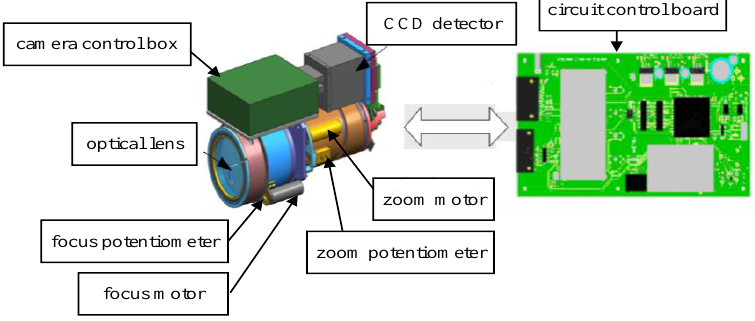
Figure 1. Visible-light camera hardware structure.